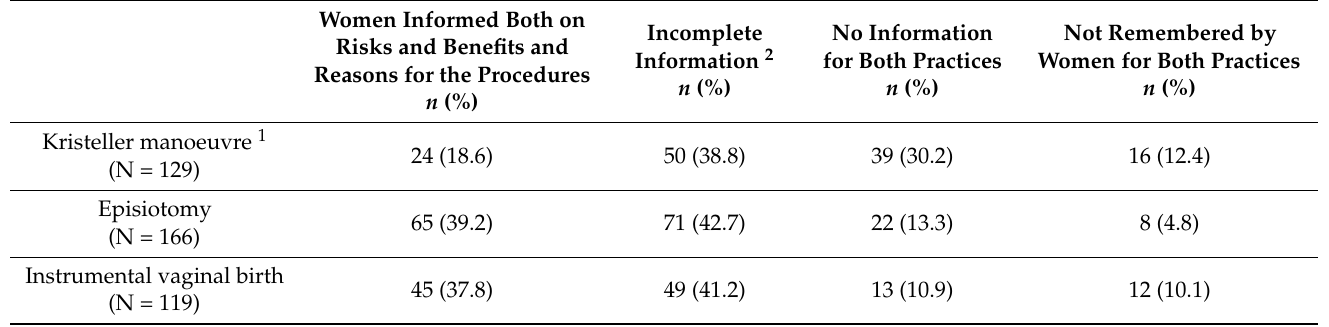
Table 2. Quality of information delivered by health workers * prior to consent requests.